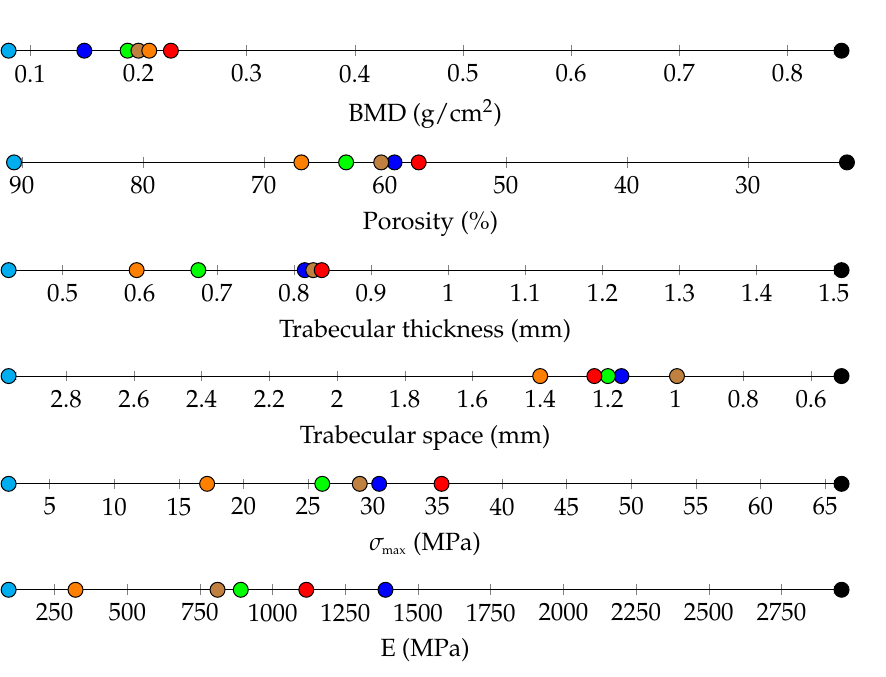
Figure 9. Comparison of all the measurements made on our cube samples. Color coding is the same as in Figure 8. Note that scales in porosity and Tb.Sp go in opposite direction with respect to others (decreasing from left to right) for comparison